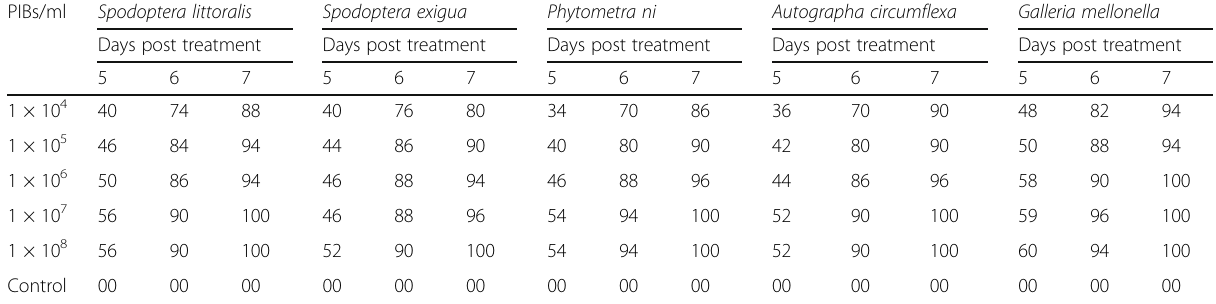
Table 1 Accumulated mortality % in 5 lepidopteran species fed on Spodoptera littoralis nucleopolyhedrovirus extracted from droppings of Bubulcus ibis fed on diseased larvae